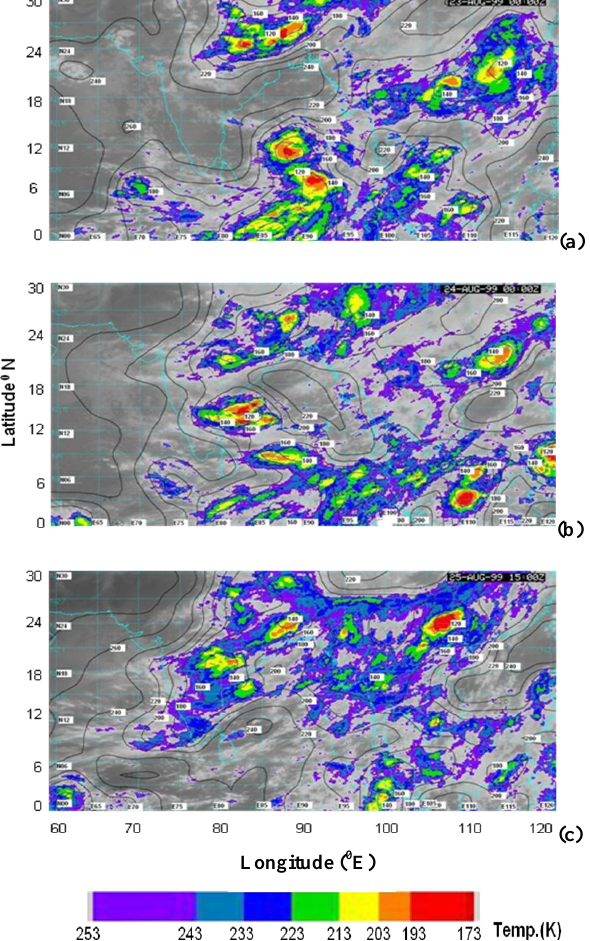
Fig. 3. INSAT-1D imagery along with cloud top temperature (CTT) are shown for three events. Contour maps of OLR (Wm − 2 ) are drawn in black lines. Separation between OLR lines is 20Wm − 2 . Three panels of this figure correspond to (a) 23 August 1999, 00:00GMT, (b) 24 August 1999, 00:00GMT and (c) 25 August 1999,